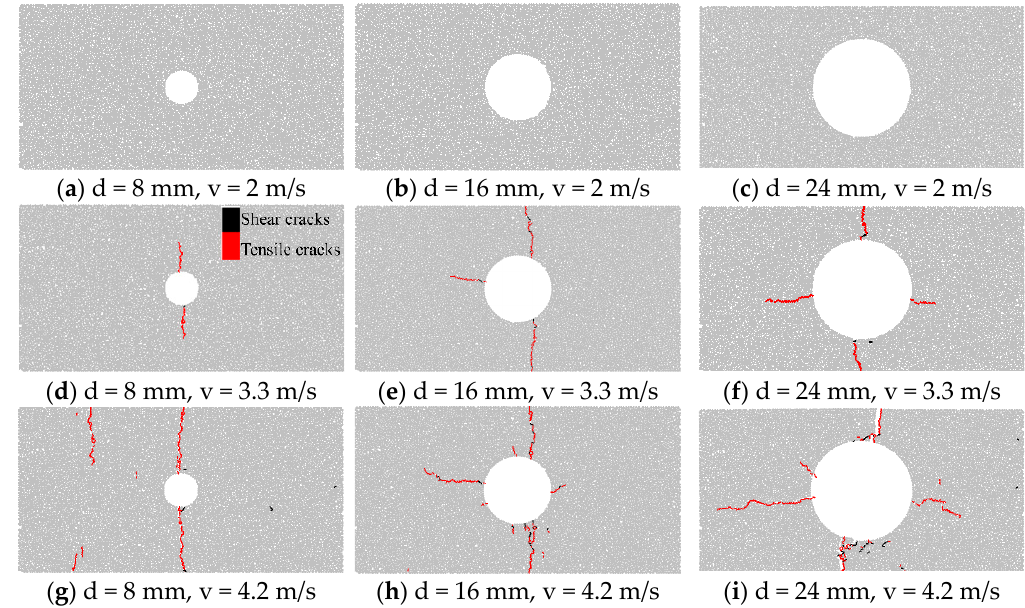
Figure 9. Final failure mode around the hole.